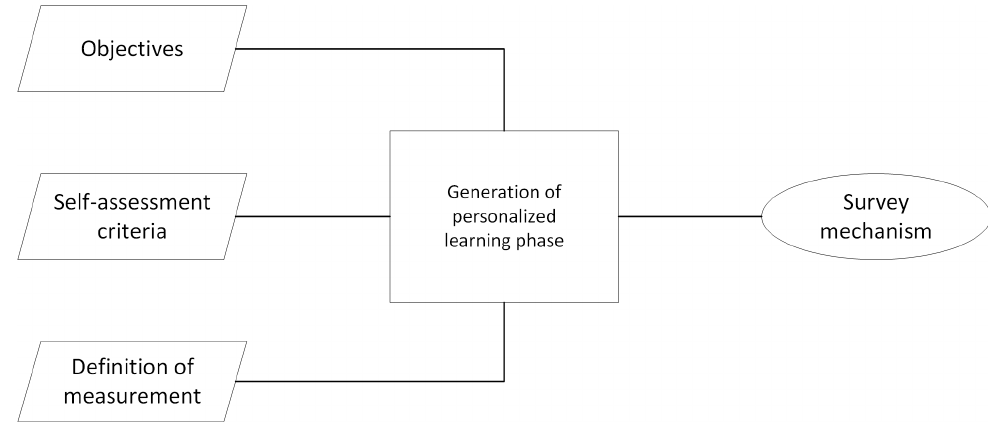
Figure 4. Ontology based approach—level 1.